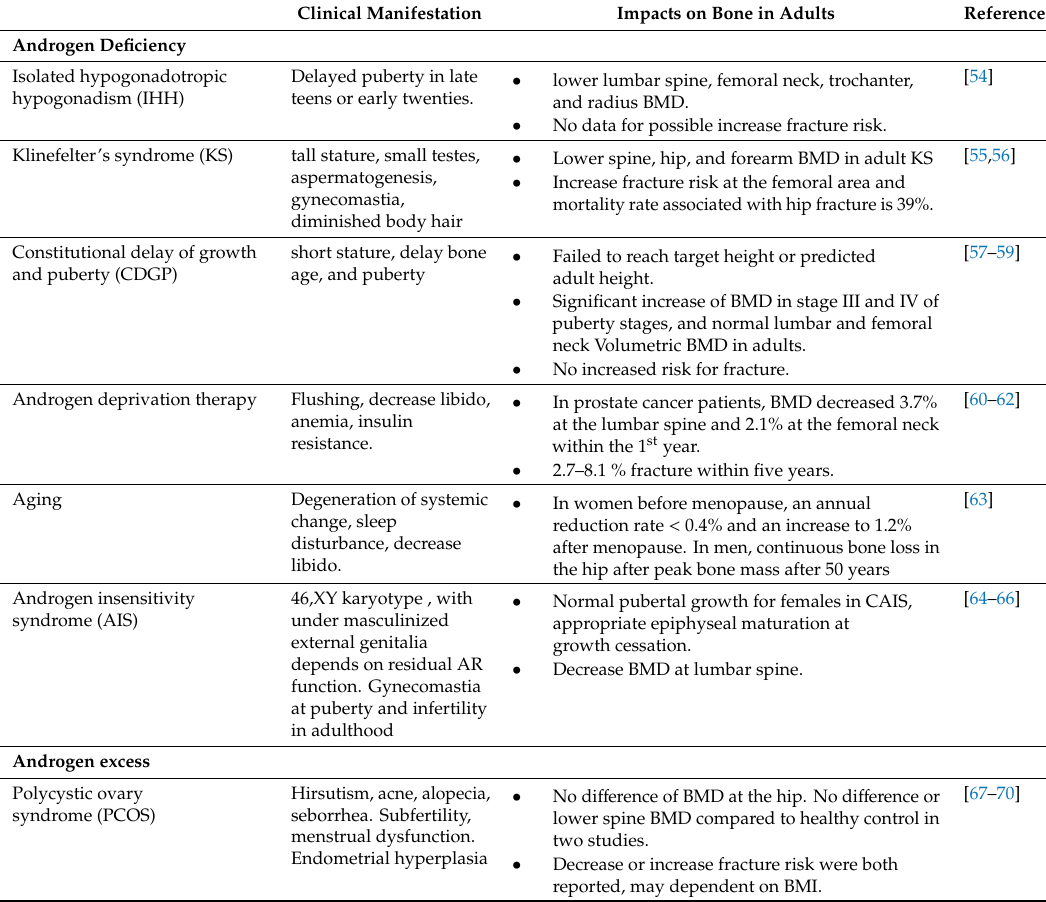
Table 1. Summary of impacts on bone in di ff erent disease associated with androgen deficiency or excess. Clinical